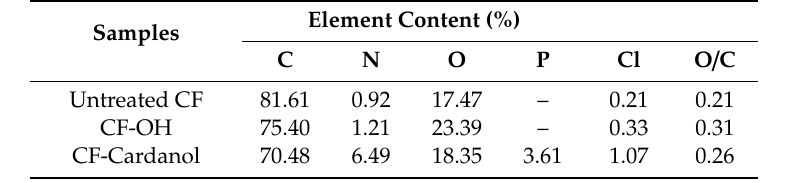
Table 1. Surface element analysis of the carbon fibers (CFs).